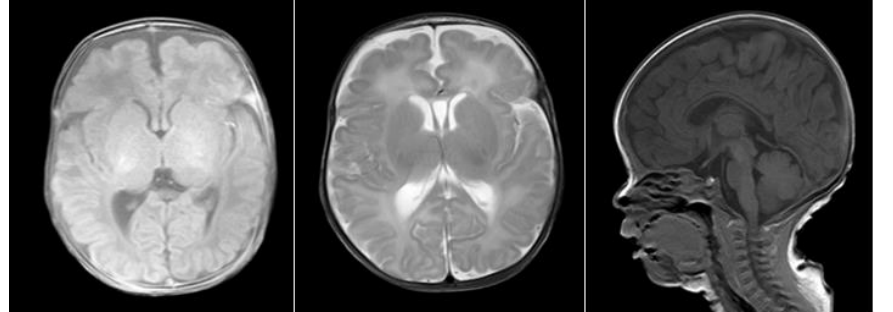
Figure 1. Proband’s cranial MRI (TIW−SE, T2W−SE, TIW−SAG).